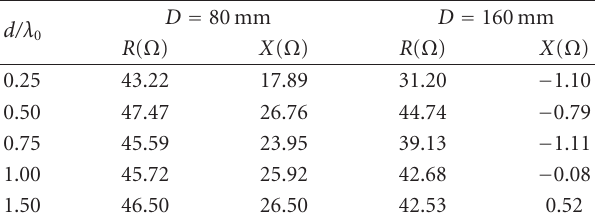
Table 3: E ff ect of the distance from the introduced conducting boundary to the monopoles’ top end on the monopole antenna’s self-impedance Z = R + X ( f = 0 .